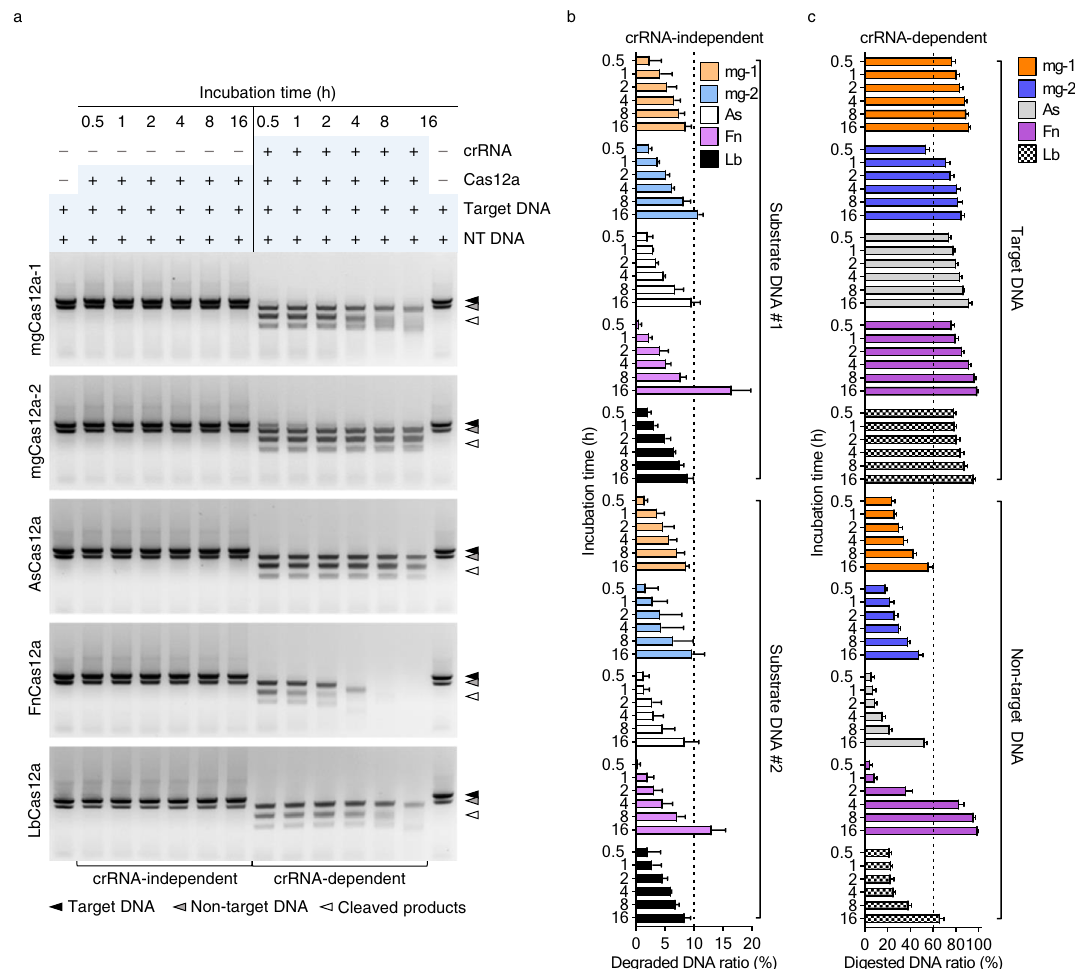
Figure 5. Collateral DNase activity is preserved in mgCas12a proteins. ( a ) Assessment of collateral dsDNase activity of the Cas12a protein family. Cas12a RNP complexes were incubated with target and non-target DNA at 37 °C from 30 min to 16 h. Original gels are presented in Supplementary Fig. 9. Filled arrowhead: Target DNA, 1662 bp; grey arrowhead: Non-target DNA, 1321 bp; unfilled arrowhead: Cleaved products, 978 bp + 684 bp. ( b , c ) Comparison of Cas12a-mediated RNA-independent ( b ) and RNA-dependent ( c ) random dsDNase activity on target DNA and non-target DNA. The intensity of digested and undigested target DNA and non-target DNA bands shown in ( a ) and Supplementary Fig. 9 were measured with ImageJ. Error bars represent standard deviation ( n =